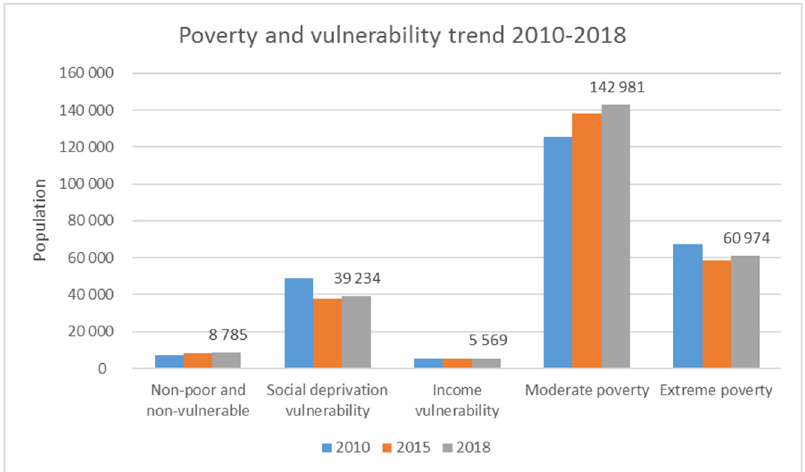
Figure 2. Poverty and vulnerability trend in Mixteca-Puebla state; authors own calculations based on data from [44].